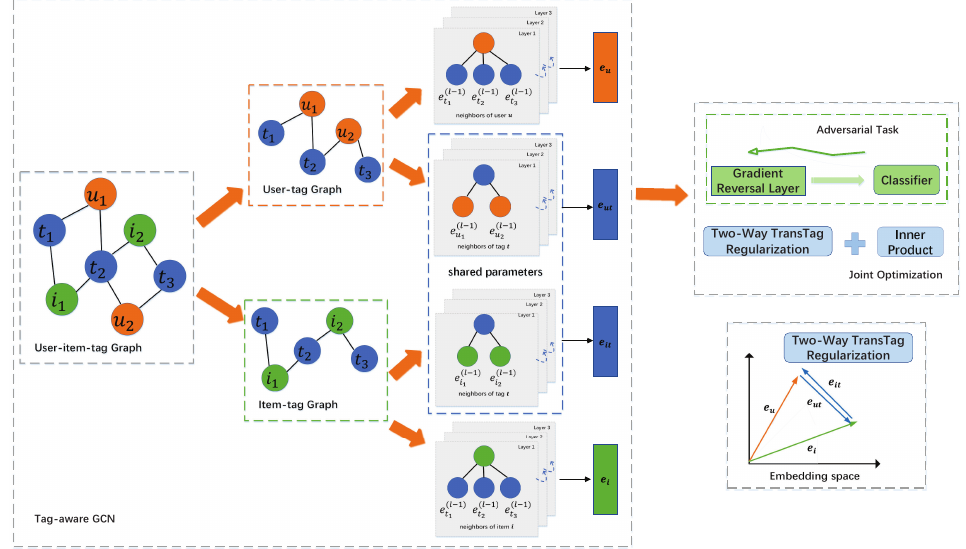
Figure 2. The overall structure of the proposed DTGCF. The user–item–tag tensor is first transformed into two undirected bipartite graphs: user–tag graph and item–tag graph. Then, a tag-aware GCN is established to generate representations of users, items, and tags, respectively. Finally, the proposed model is trained in an end-to-end way with a joint learning framework, which combines the recom- mendation task with an adversarial task and a two-way TransTag regularization. The lower right corner of the figure illustrates the two-way TransTag regularization which models the relationship among users, items, and